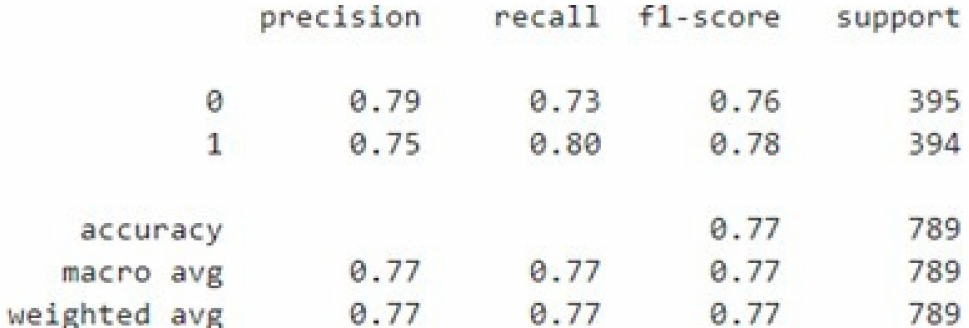
Figure 5. Decision Tree Classification